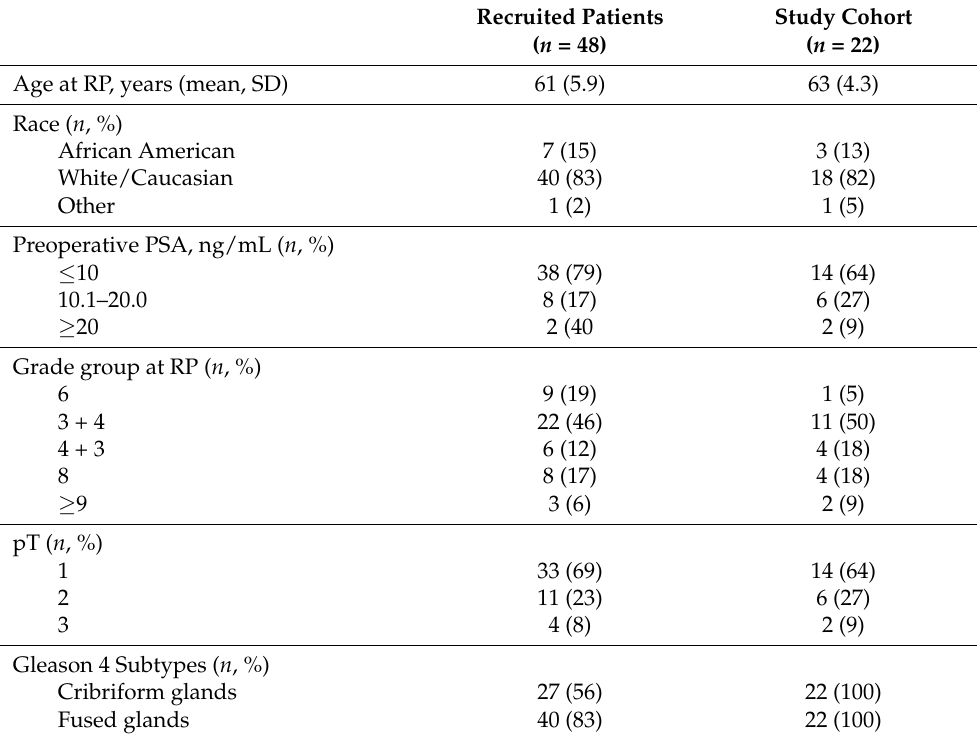
Table 1. Demographic information for the patient cohort at the time of radical prostatectomy (RP). Recruited